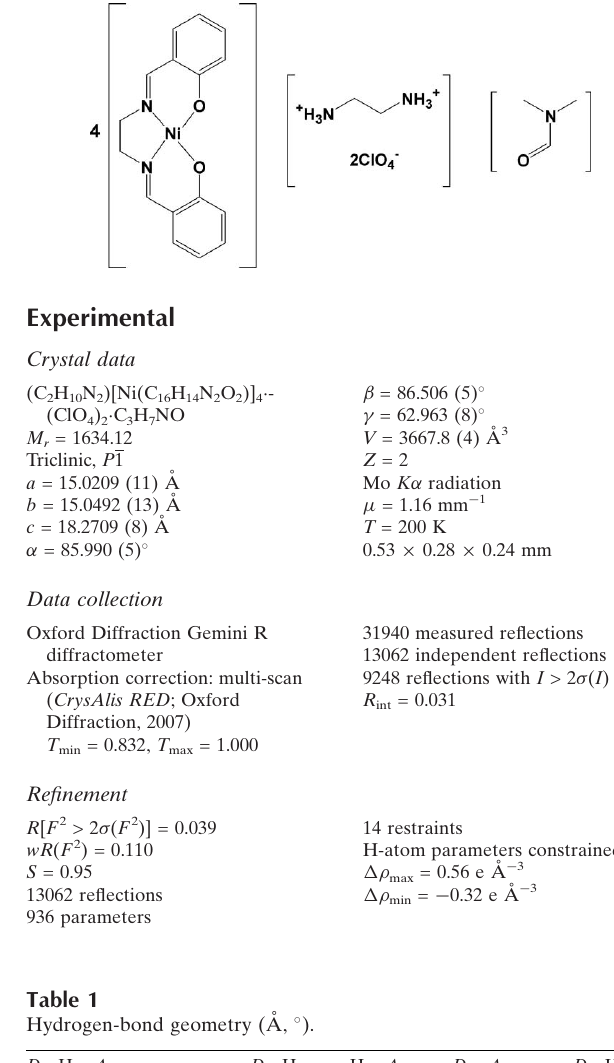
Hydrogen-bond geometry (A˚ , (cid:3) ). D —H (cid:2)(cid:2)(cid:2) A D —H